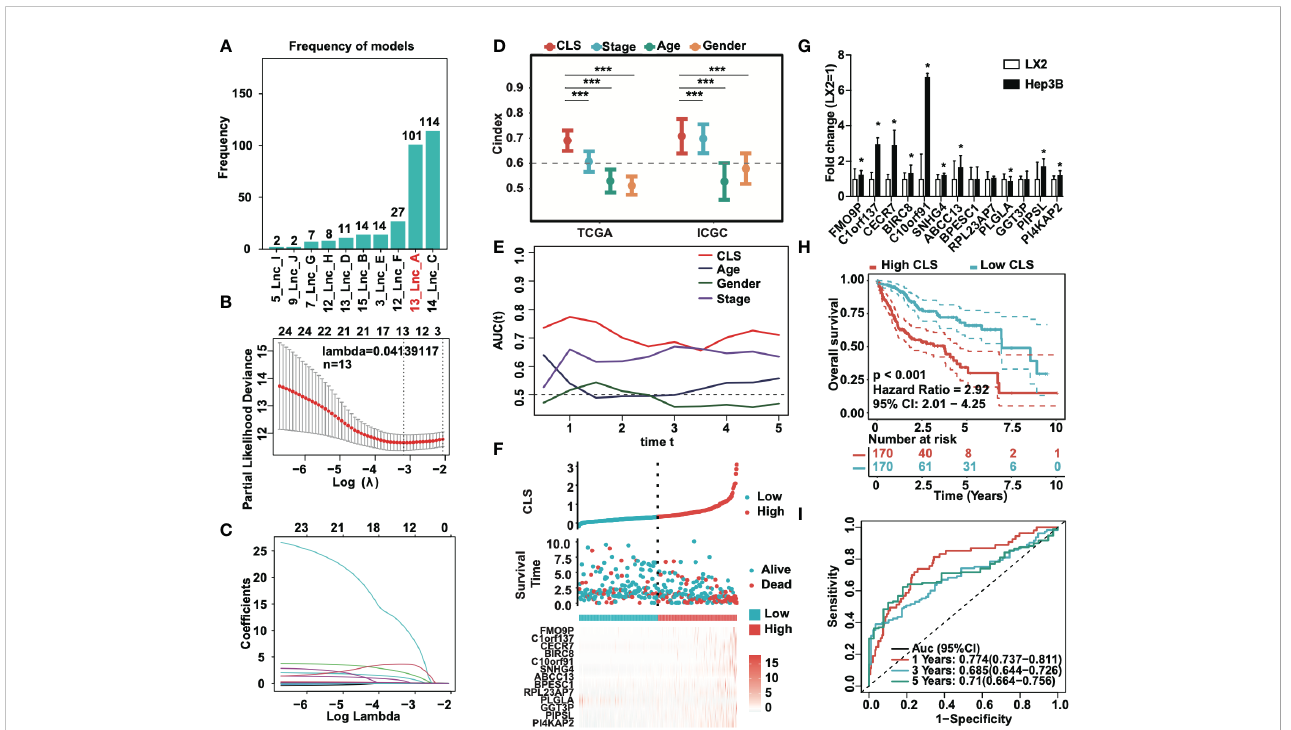
FIGURE 2 Prognostic signature based on CLS was created. (A) Lasso regression of the cuproptosis-related lncRNAs. (B) Identi fi cation of the tuning parameter in Lasso model. (C) The coef fi cients in Lasso model. (D) The C-index of CLS, stage, age and gender in TCGA and ICGC databases. (E) The AUC of CLS, age, gender and stage in TCGA. (F) The survival status and the expression of the 13 cuproptosis-related lncRNAs of each sample ranked from high to low CLS. (G) The mRNA expression of 13 cuproptosis-related lncRNAs in HCC cell line Hep3B compared to the hepatic stellate cell line LX2. (H) Kaplan-Meier analysis of the high and low CLS patients. (I) The 1-, 3- and 5-year AUC of the prognostic signature. *P-value < 0.05, ***P-value <